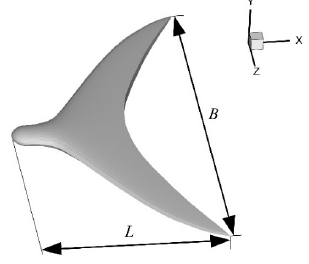
Figure 1. Geometric model of the fin.